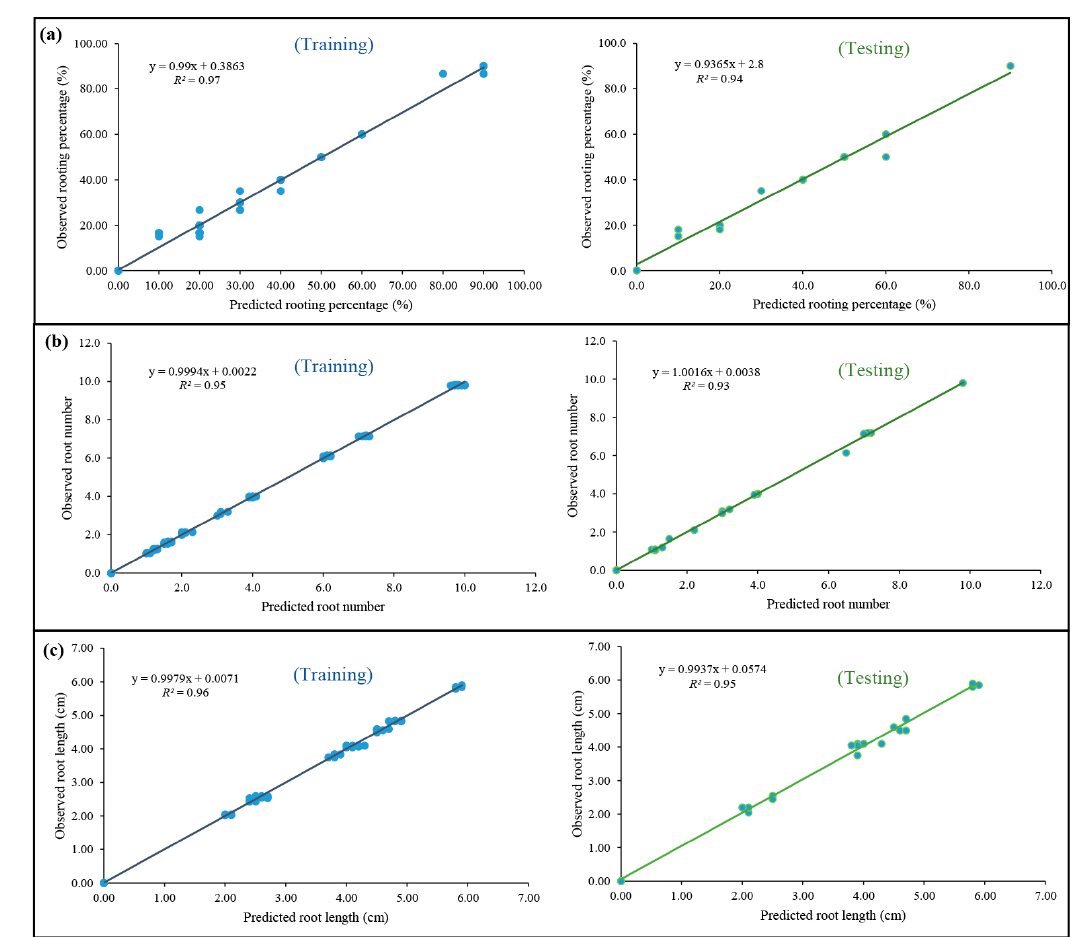
Figure 5. Scatter plot of values of observations vs. predictions in training sets and testing sets of ( a ) rooting percentage, ( b ) root number, and ( c ) root length in P. caerulea .